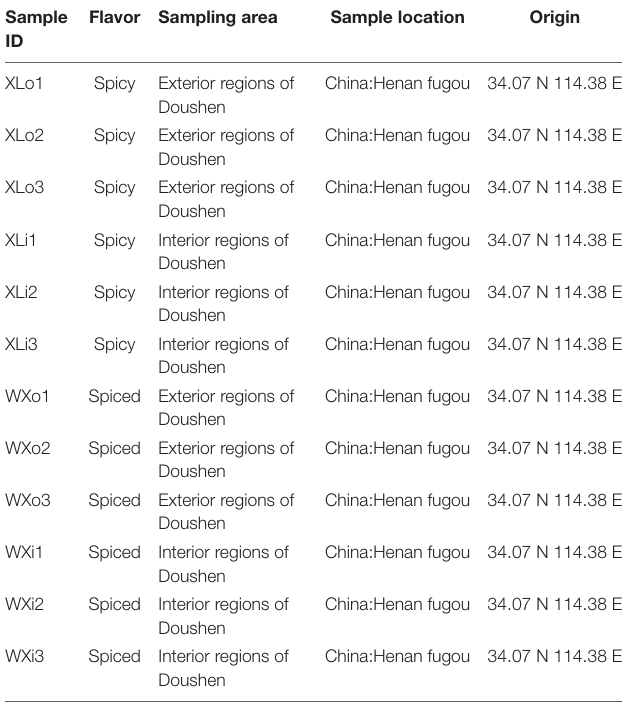
TABLE 1 | Information of Doushen samples with different